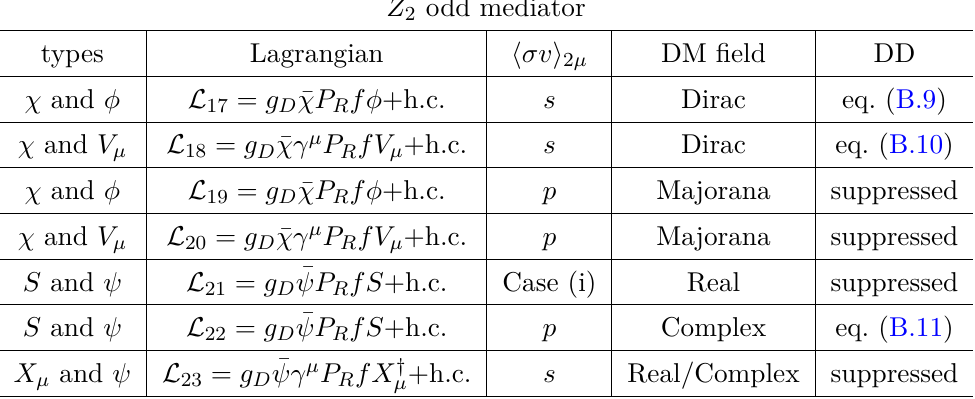
Table 3 . All representative interaction types among Z 2 -odd mediator, DM and right handed muon. The operator P = (1 + γ 5 ) / 2 refers to the right-handed projection. R